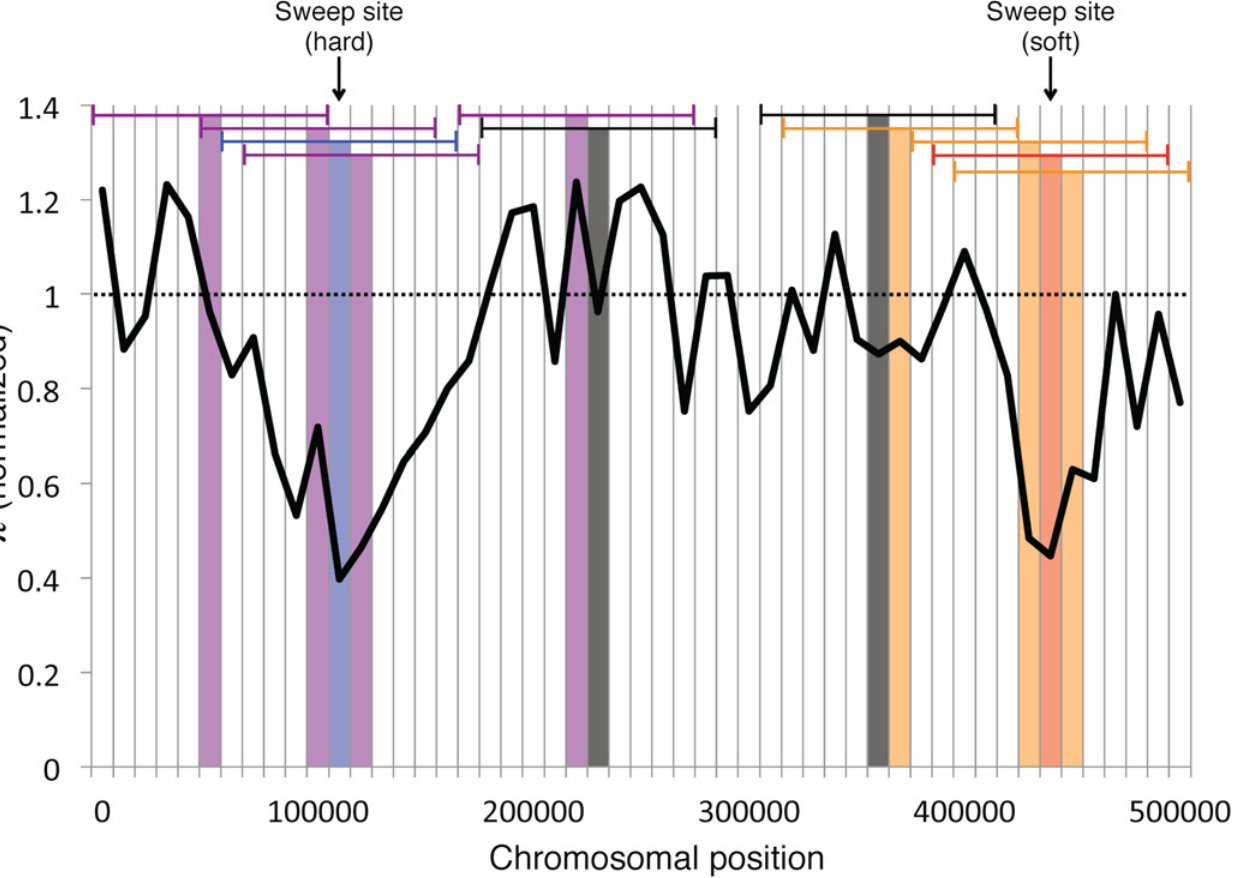
Fig 1. Examples of the five classes used by S/HIC. S/HIC classifies each window as a hard sweep (blue), linked to a hard sweep (purple), a soft sweep (red), linked to a soft sweep (orange), or neutral (gray). This classifier accomplishes this by examining values of various summary statistics in 11 different windows in order to infer the mode of evolution in the central window (the horizontal blue, purple, red, orange, and gray brackets). Regions that are centered on a hard (soft) selective sweep are defined as hard (soft). Regions that are not centered on selective sweeps but have their diversity impacted by a hard (soft) selective sweep but are not centered on the sweep are defined as hard-linked (soft-linked). Remaining windows are defined as neutral. S/HIC is trained on simulated examples of these five classes in order to distinguish selective sweeps from linked and neutral regions in population genomic data.